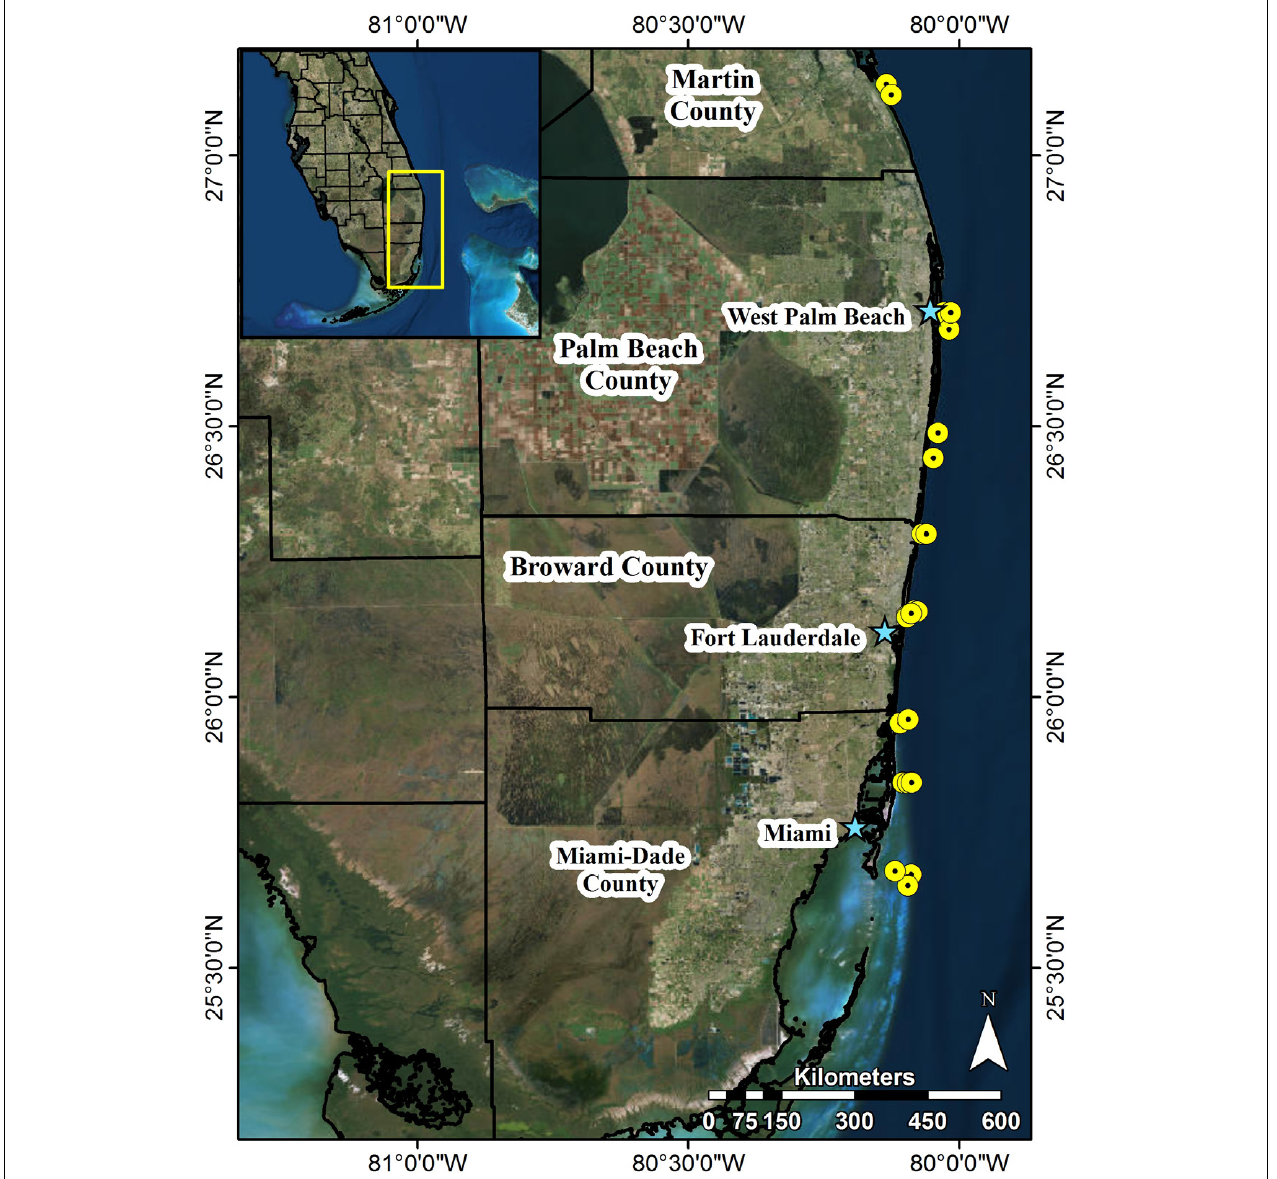
FIGURE 1 | Map of southeast Florida and locations of 22 permanent SECREMP monitoring sites. Each yellow point represents sites, stars name major metropolitan areas, and black outlines represent county boundaries. Site names and descriptive data are included in Table 1